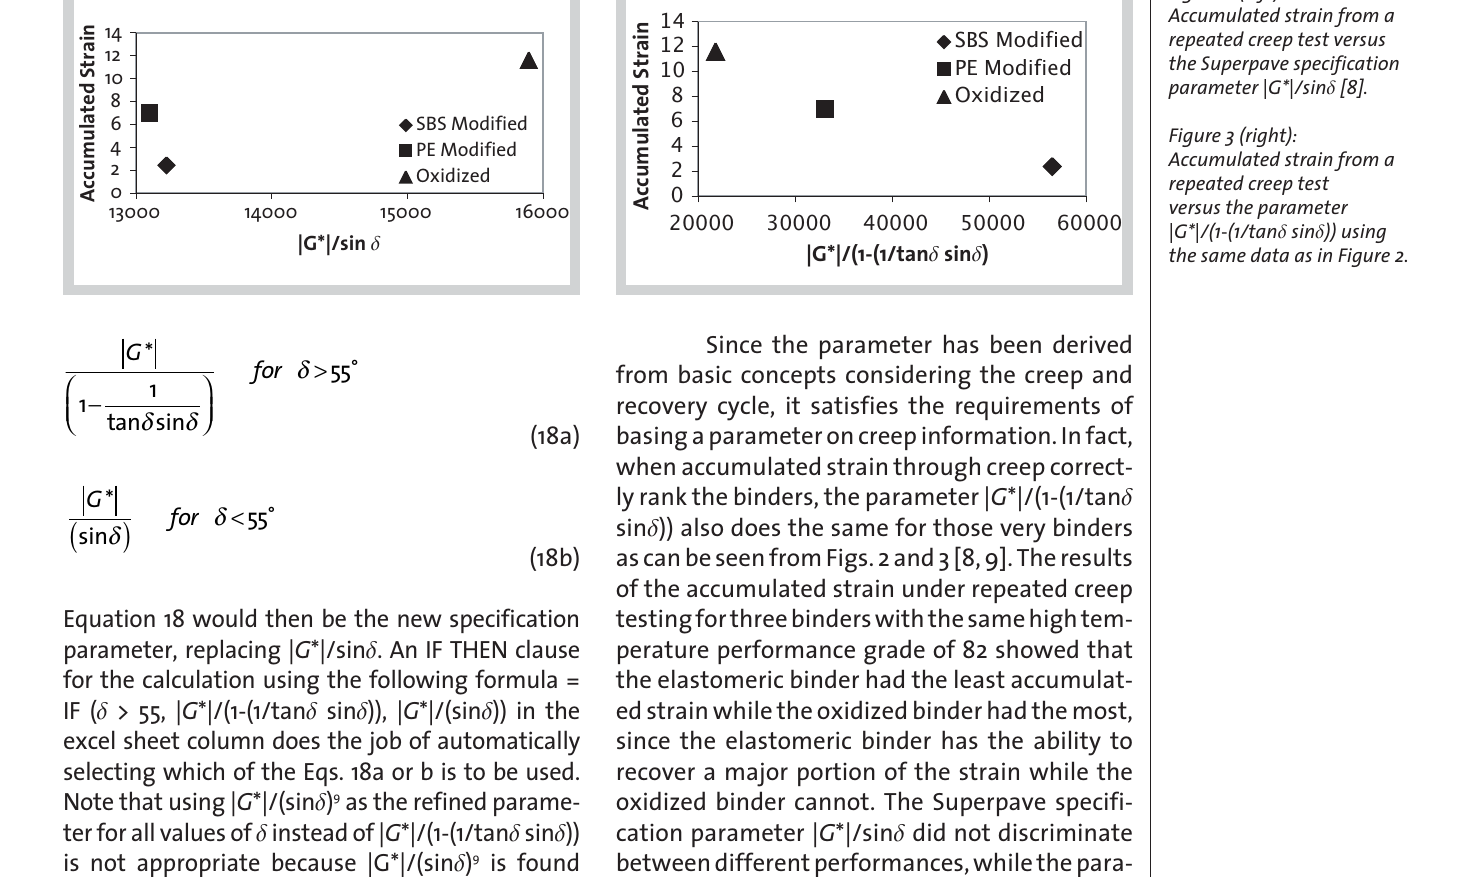
Figure 2 (left): Accumulated strain from a repeated creep test versus the Superpave specification parameter |G*|/sin d [8]. Figure 3 (right): Accumulated strain from a repeated creep test versus the parameter |G*|/(1-(1/tan d sin d )) using the same data as in Figure